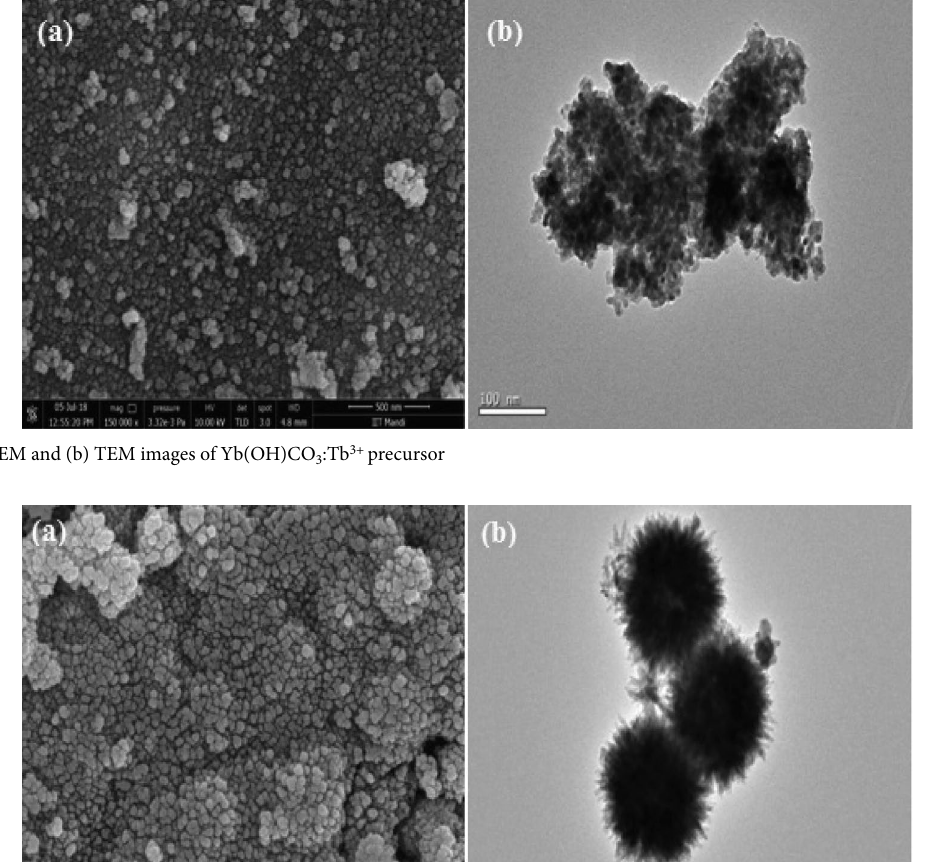
Figure 8. (a) SEM and (b) TEM images of YbPO 4 :Tb 3+ (Sac)